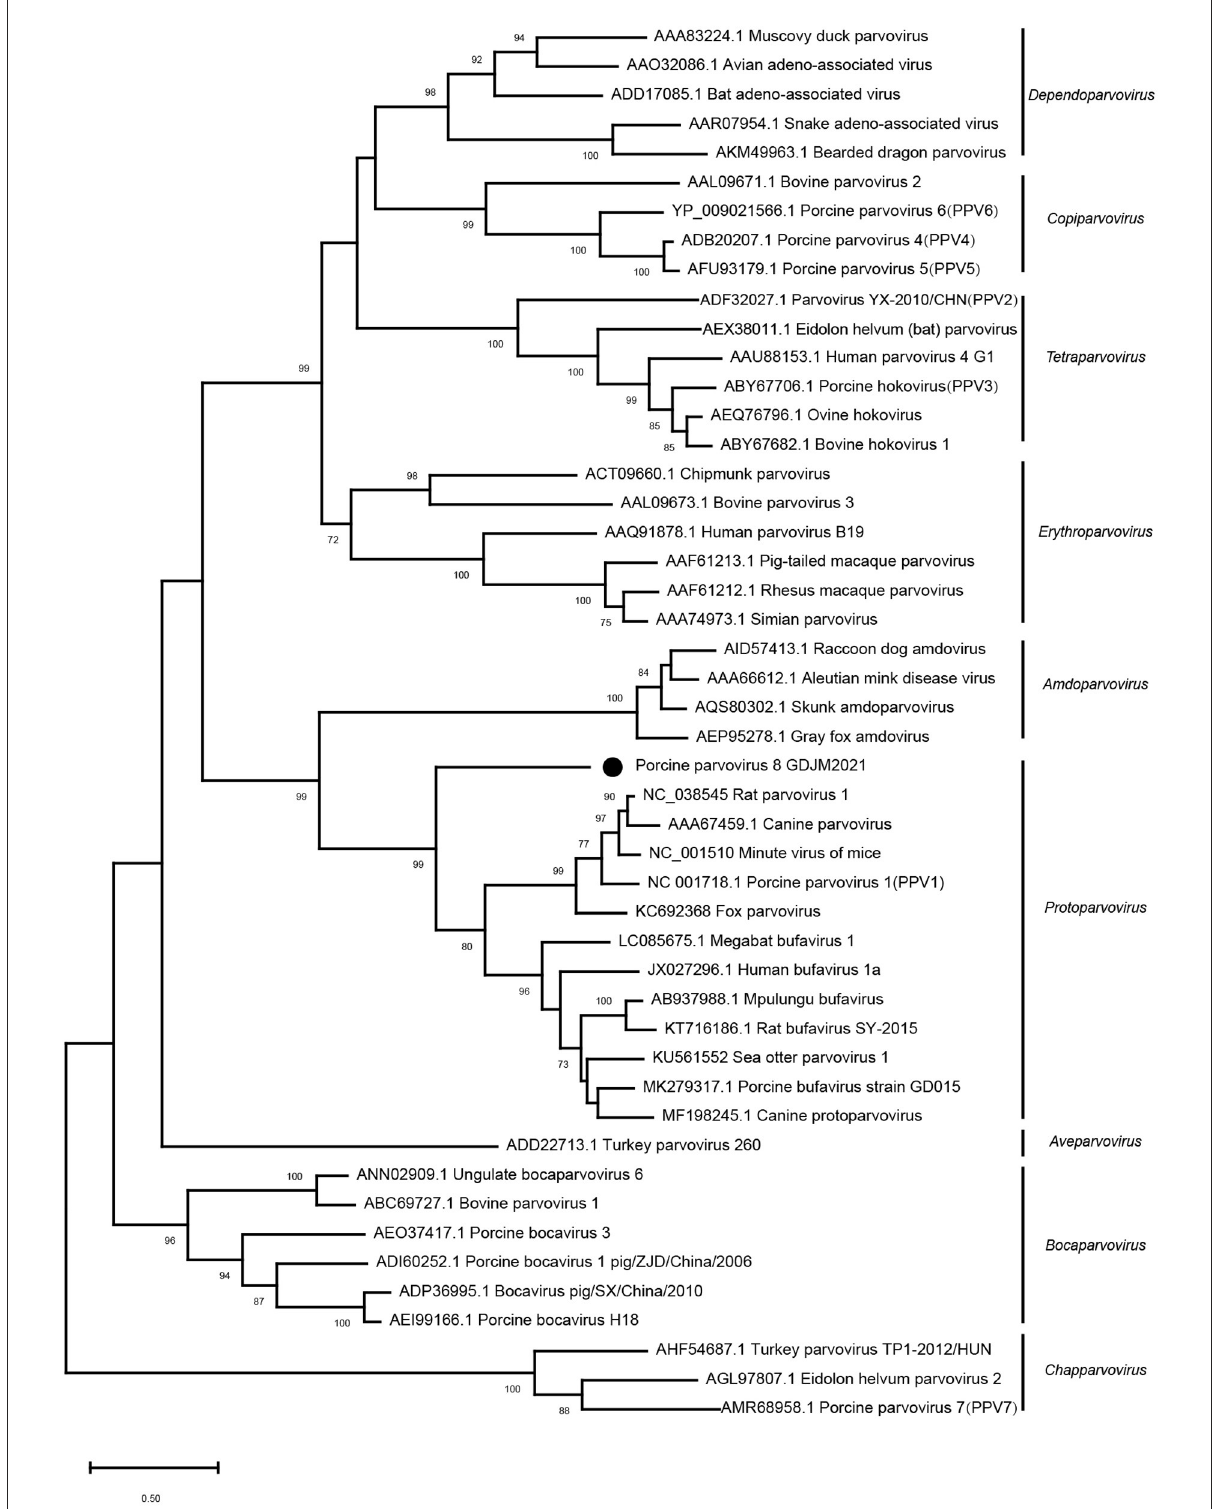
FIGURE2 Phylogenetic trees of parvoviruses. Phylogenetic analysis was constructed based on full-length aa sequences of NS1 protein of PPV8-GDJM2021 and other reference strains of nine parvovirus genera retrieved from GenBank by MEGA X using the maximum-likelihood (ML) method and 1,000 bootstrap